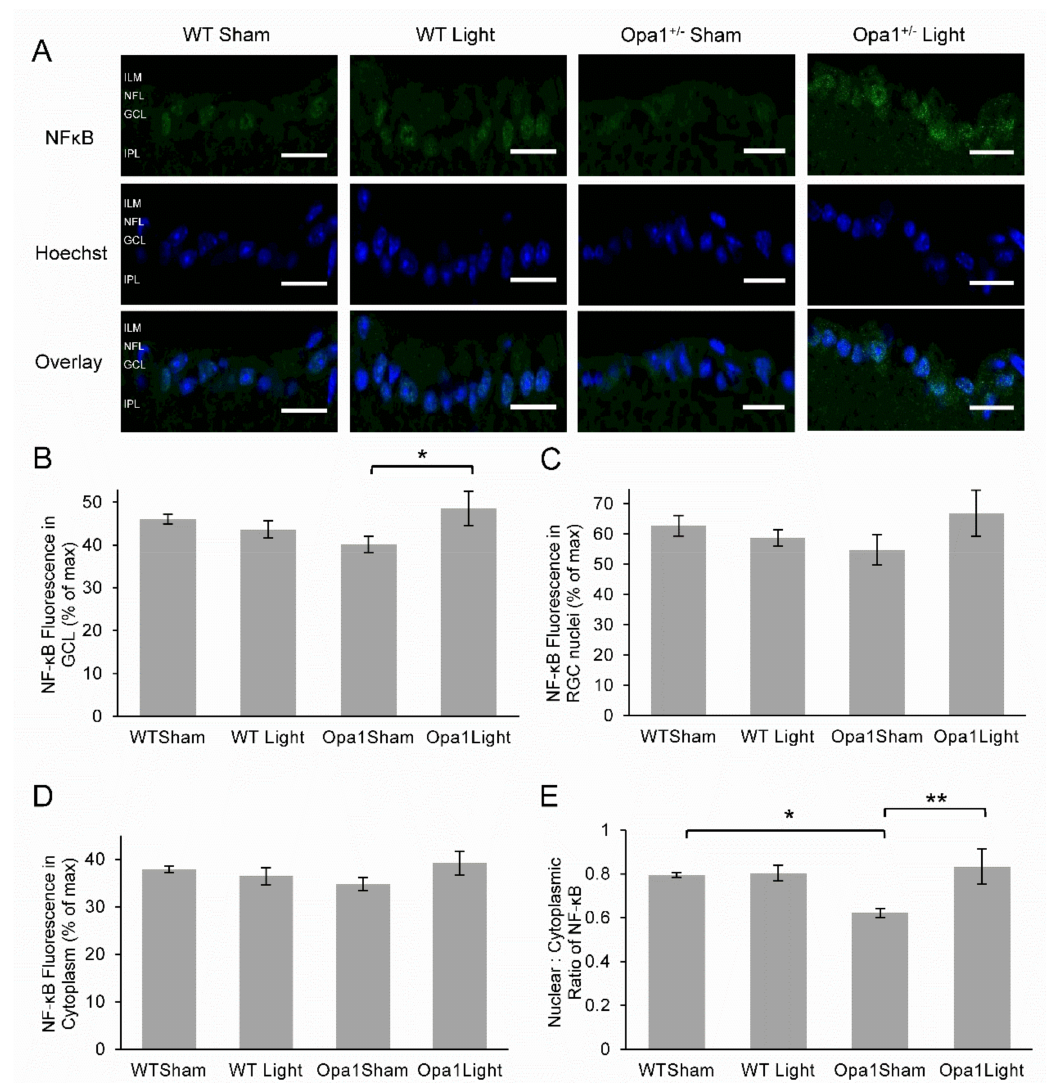
Figure 6. Immunohistochemical analysis of NF- κ B expression in the GCL. ( A ) Representative images of the GCL taken at 60 × magnification. The top row shows NF- κ B staining in green, the middle rows depict a blue nuclear stain, and the bottom row displays the overlay. ILM: inner limiting membrane; NFL: nerve fiber layer; GCL: ganglion cell layer; IPL: inner plexiform layer. Scale bar represents 20 µ m. ( B ) The mean fluorescence was quantified in the GLC and showed no significant differences. ( C ) NF- κ B fluorescence was reduced in the GCL nuclei of light-treated WT mice compared to sham-treated WT controls. ( D ) Cytoplasmic NF- κ B was reduced in the GCL of both sham-treated Opa1 +/ − and light-treated WT mice compared to WT controls. ( E ) The nuclear: cytoplasmic ratio, representing NF- κ B activation, was significantly decreased in the Opa1 +/ − Sham group compared to WT controls. However, this decrease was not observed in mutant mice pre-treated with 670 nm light. WT Sham ( n = 3), WT Light ( n = 6), Opa1 +/ − Sham ( n = 4) and Opa1 +/ − Light ( n = 3). * p < 0.05, ** p < 0.01 two-way